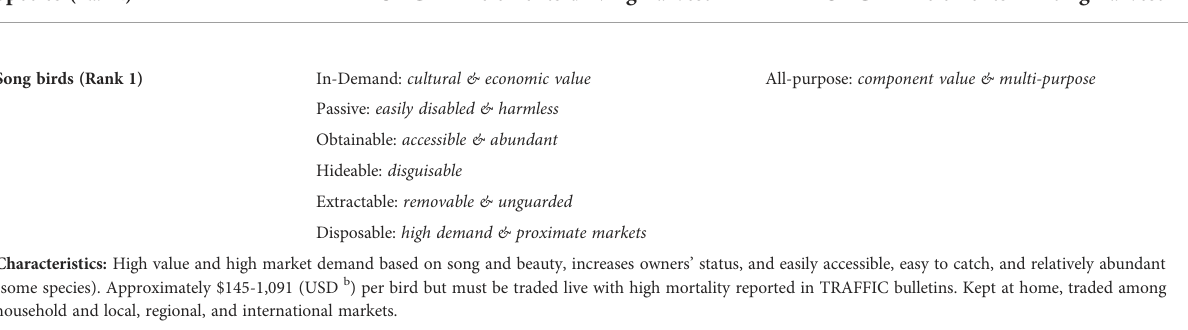
TABLE 5 IPOACHED elements that drive and limit poaching of the top 3 most frequently poached species or genera and the “ big 3 ” (elephants, rhinos, tigers) species of Bukit Barisan Selatan National Park, Sumatra, Indonesia according to focus group participantsa a (n=27). Species